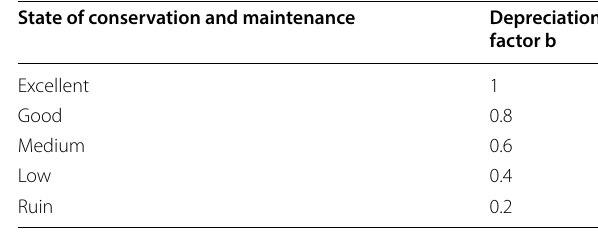
Table 1 Criteria for the assignment of the depreciation factor b according to the state of conservation and maintenance of the